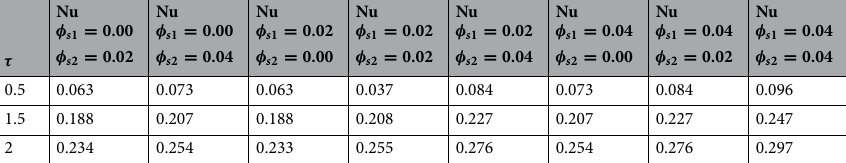
Table 7. The variation in Nusselt number for various values of volume fractions of hybrid